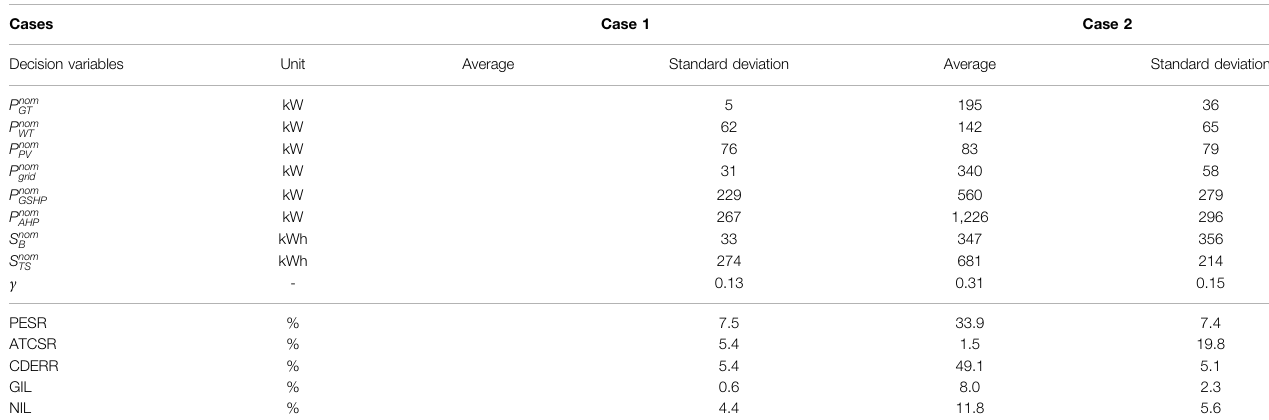
TABLE 5 | Distributions of optimal solutions of two cases Cases